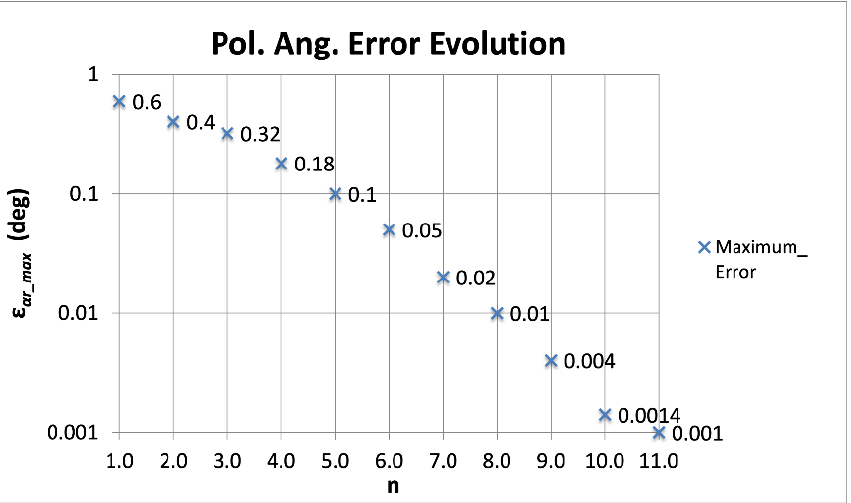
Figure 7. Evolution of the maximum polarization angle error ( ε α r_max ) as a function of the number of terms ( n ) of ε α f , considering the four outputs of the polarimeter.